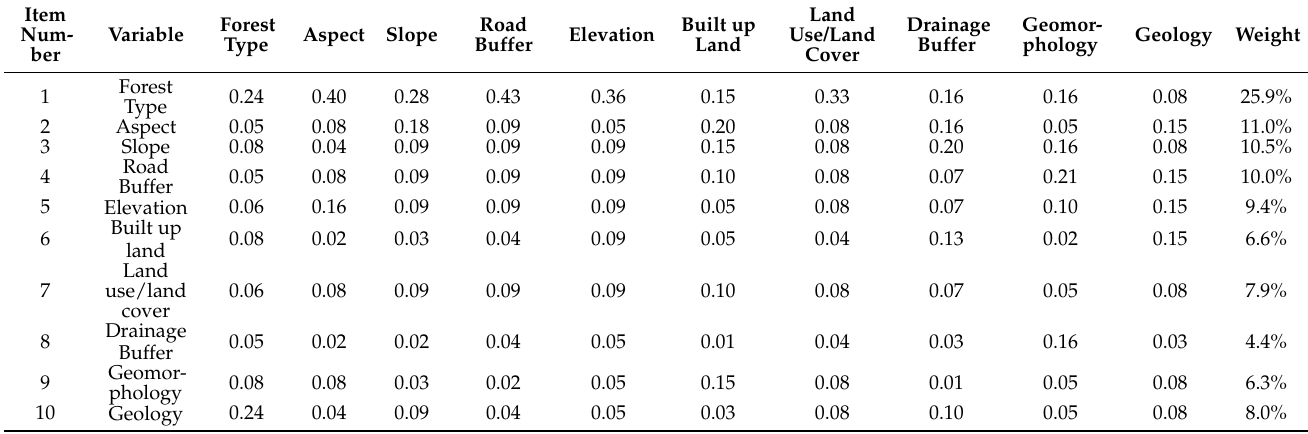
Table 4. Weighted values assigned to each